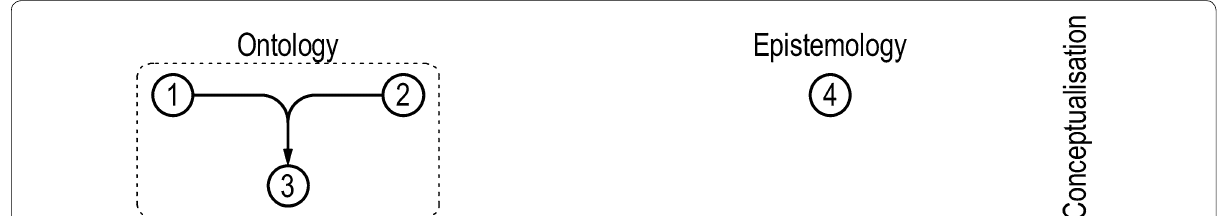
Fig. 1 Criticism connections and groupings of Alexander’s second theory of architecture: conceptualisation. Numbers correspond to criticism num- bers in text and tables, dotted lines indicate groups and sub-groups of criticisms, arrows point from antecedent criticisms to secondary criticisms or groups of